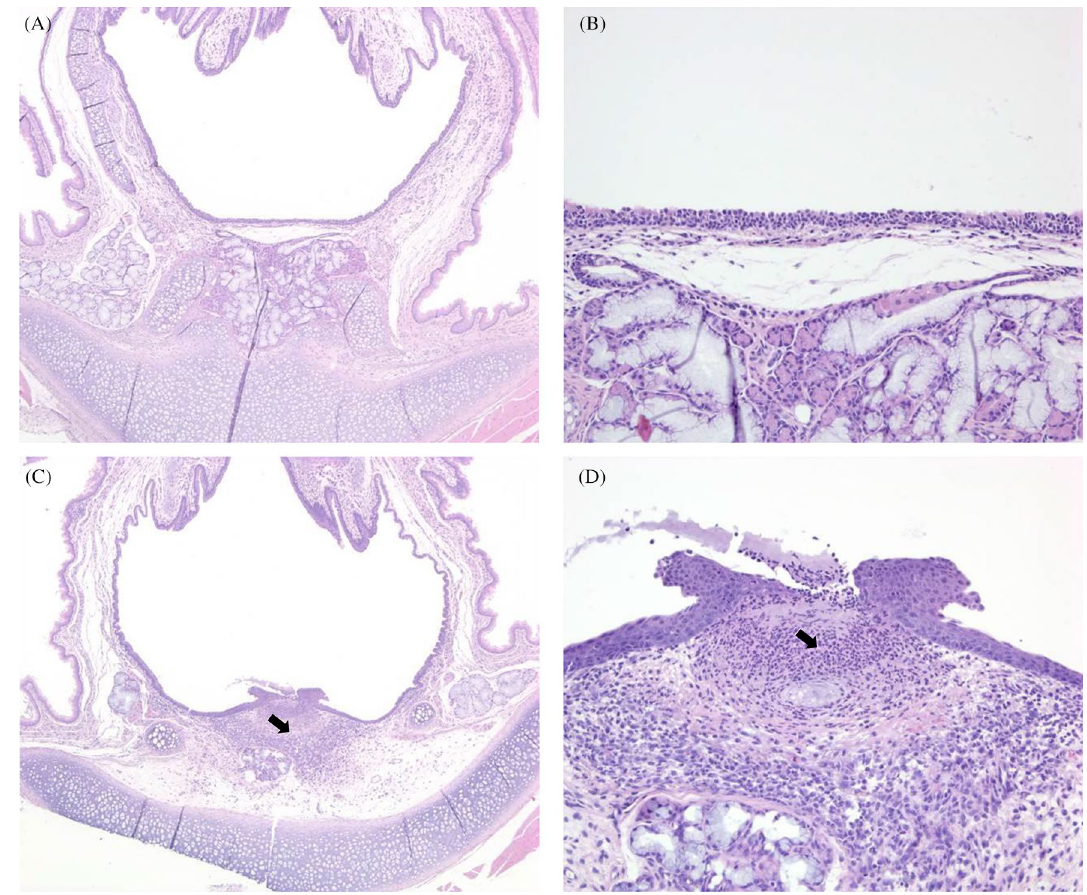
Figure 7. Histopathology of the larynx of male rats exposed to NaDCC, ( A , B ) No abnormal lesion was observed in the control group, ( C , D ) Inflammation (arrow) of epithelium was observed in the 20 mg/m 3 exposed group. ( A , C ) × 50, ( B , D ) × 400, respectively,